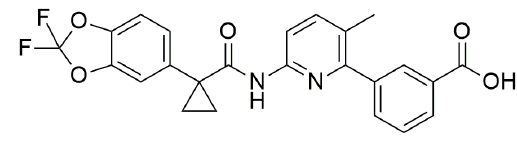
Figure 11. Structure of Lumacaftor.